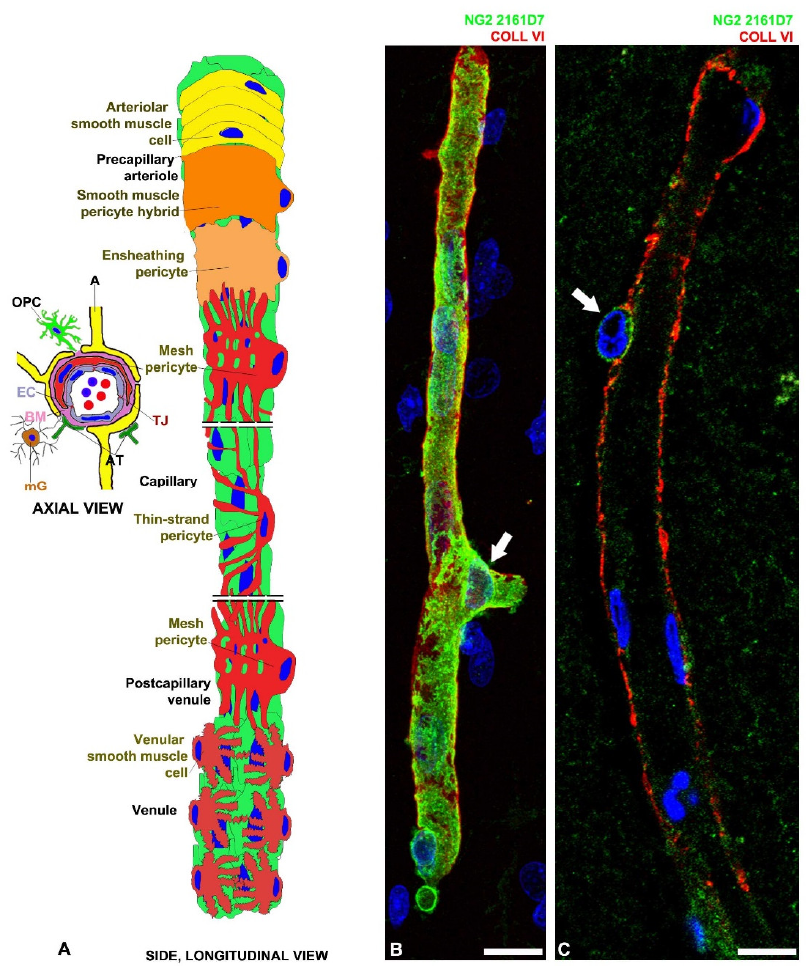
Figure 1. ( A ) A schematic depiction of NVU components from axial and longitudinal views: endothelial cell (EC), pericyte (PC), perivascular basement membrane (BM), and astrocytes (A), vessel-associated microglial cells (mG), OPCs/NG2-glia, macrophages, axon terminals (AT) which can contact EC. The longitudinal drawing shows mural cell types along the CNS vasculature without considering the presence of continuous BM between ECs and PCs. Smooth muscle cells wrap the arterioles, forming multiple concentric rings in continuity with hybrid smooth-muscle-PCs residing along the precapillary arterioles, which appear to join to ensheathing PCs at the arteriole–capillary interface. PCs in microvessels typically exhibit two phenotypes: the mesh PC characterized by short ramified processes, versus the thin-strand PC with long processes embracing the microvessel in a single strand, or helically twisted strand pairs. Mesh PCs prevail at the capillary–postcapillary venule interface. Stellate-shaped smooth muscle cells are present around parenchymal venules. ( B ) The mesh PC fine morphology and microvascular basal lamina relationships are shown in a representative vessel of the dorsal wall of the telencephalic vesicles (forebrain, future neocortex) of a 22-week-old human foetus. The extensive PC coverage and its relation to the collagen VI-enriched basal lamina is highlighted by an NG2/CSPG4 isoform, specifically recognized by the antibody 2161D7, that outlines not only the finer cell details such as the dense net of finger-like processes, but also the abluminal bumpy surface of the PC body (arrow) at the branching point. ( C ) The same 2161D7 antibody, recognizing an NG2/CSPG4 isoform expressed by foetal brain PCs, weakly stains just the PC body (arrow) of the adult human parahippocampal cortex. Other monoclonal antibodies against NG2 isoforms and commercial antibodies do not stain human adult CNS PCs [19]. Nuclear counterstaining TO-PRO3. Bars B, C: 10 µ